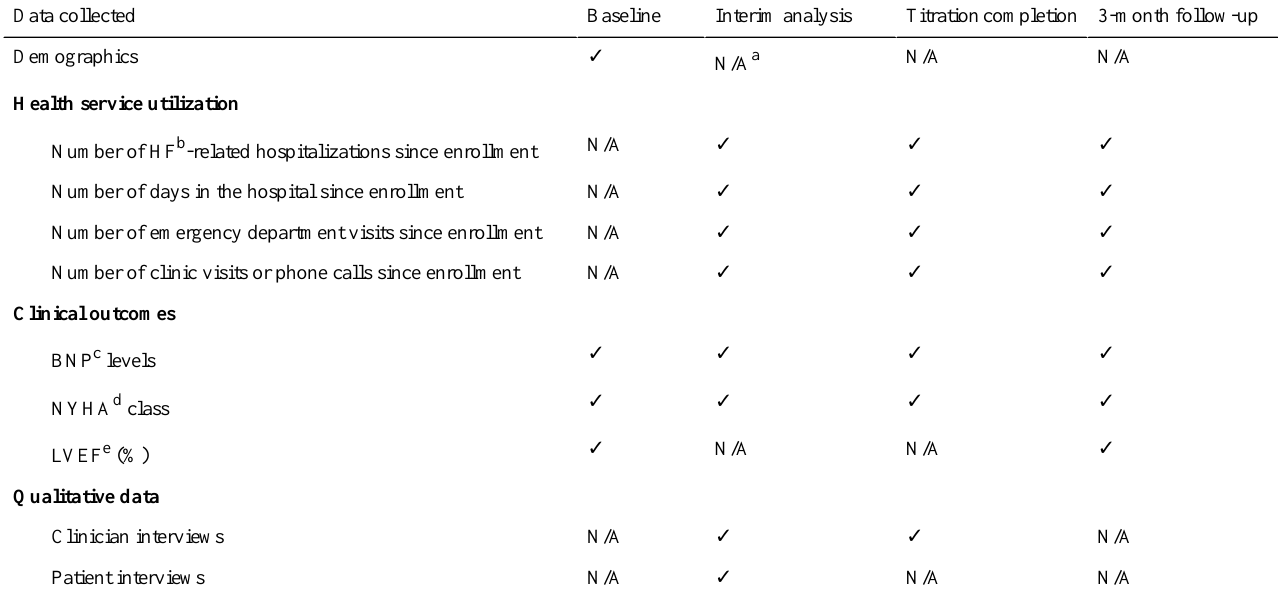
Table 1. Schedule for data acquisition indicated by checkmarks at the specified time